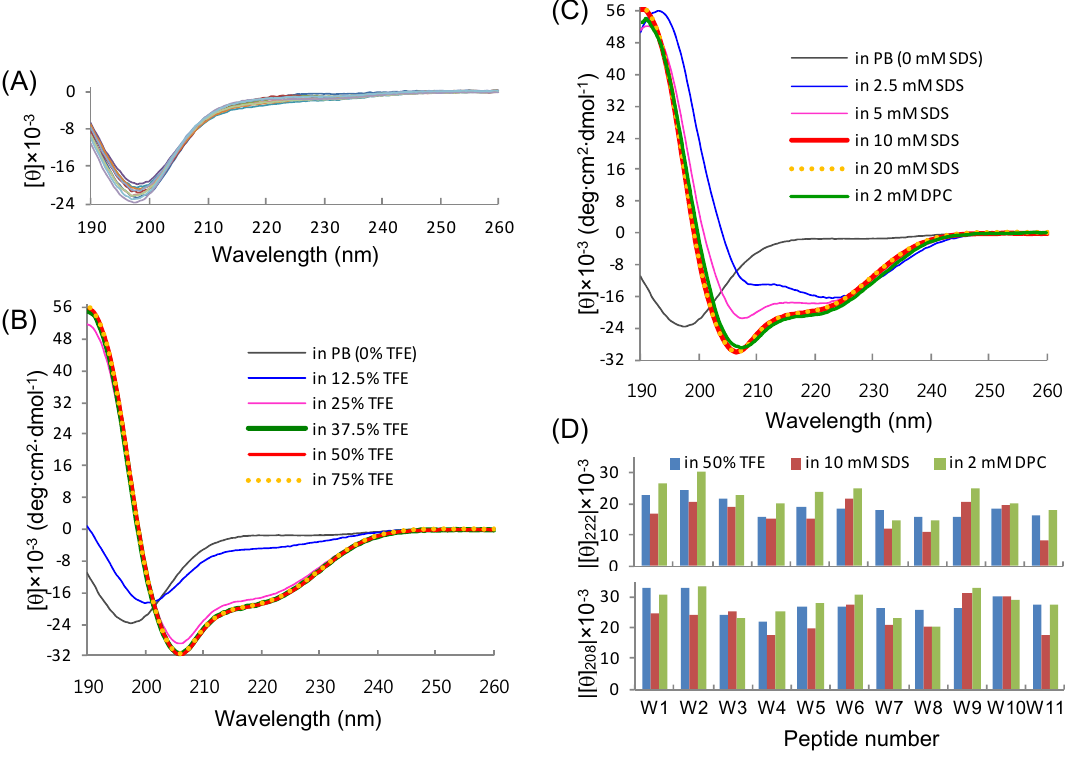
Figure 3. CD analysis of the L K W n model peptides. ( A ) Far-UV CD spectra of 5 5 individual peptides in 10 mM phosphate buffer at pH 6.5 are superimposed; ( B and C ) CD spectra of the W10 peptide in phosphate buffer containing various concentrations of TFE and detergents (SDS and DPC) are represented, respectively; ( D ) Absolute values of mean residue molar ellipticity at 222 nm ([  ] ; upper panel) and 208 nm ([  ] ; lower panel) 222 208 are plotted for individual peptides in three different